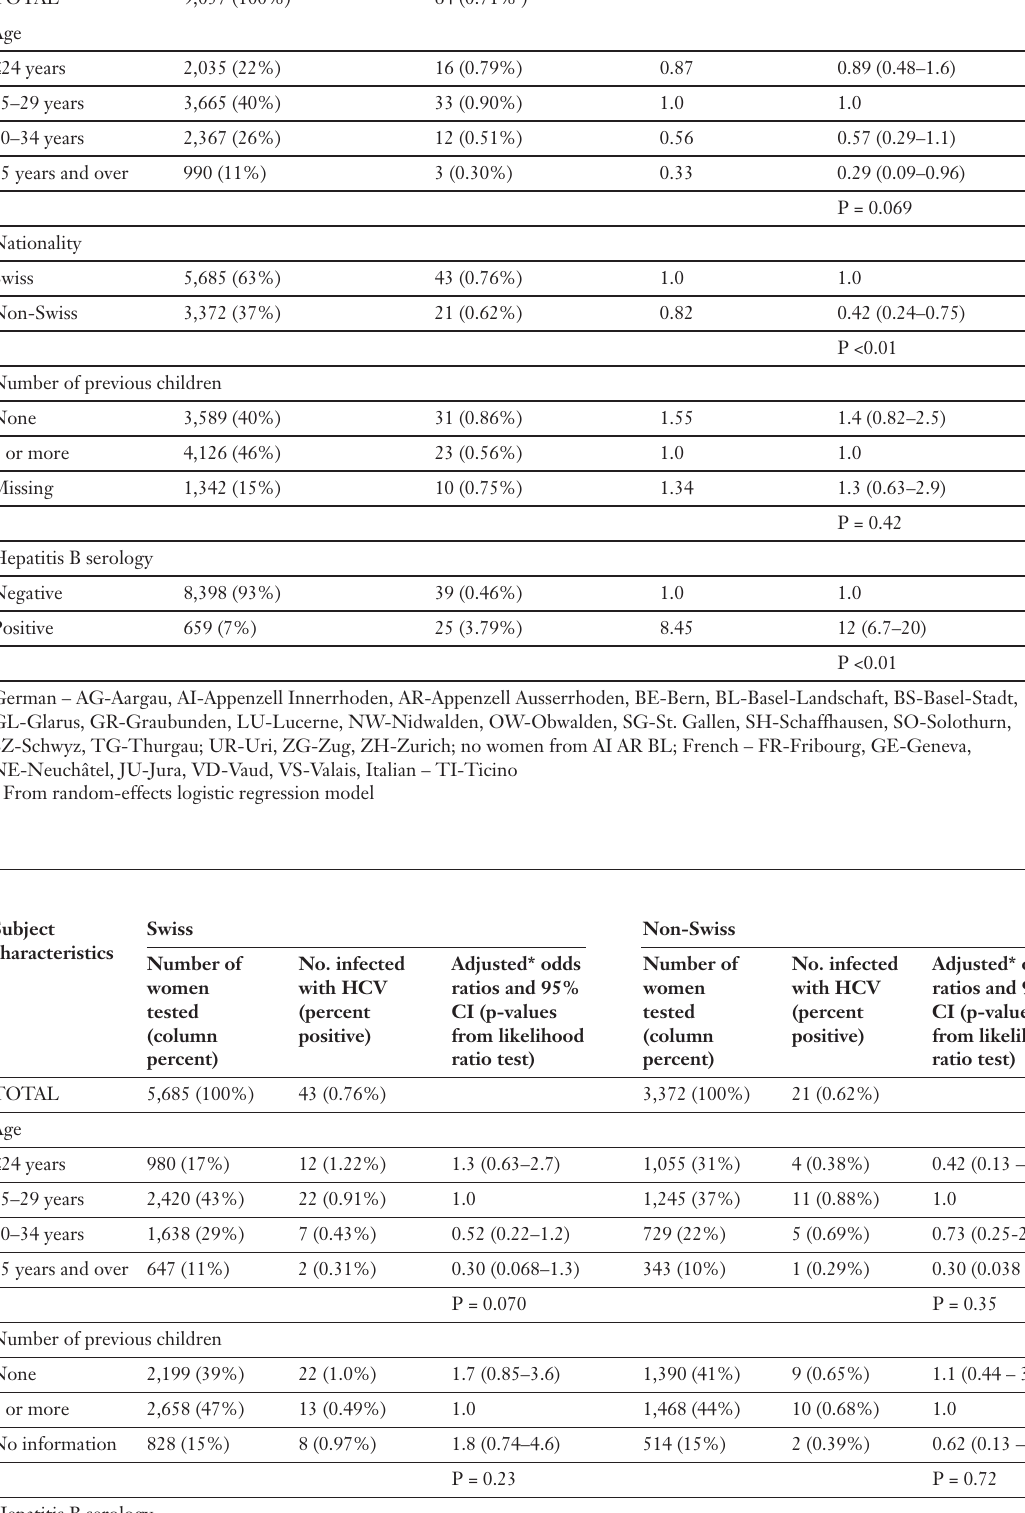
Factors associated with being HCV seropositive in a sample of pregnant women in Switzer- land.